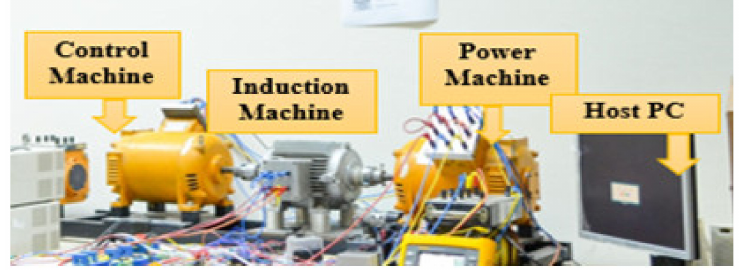
Figure A1. Cascaded induction machines implementation used in this article.